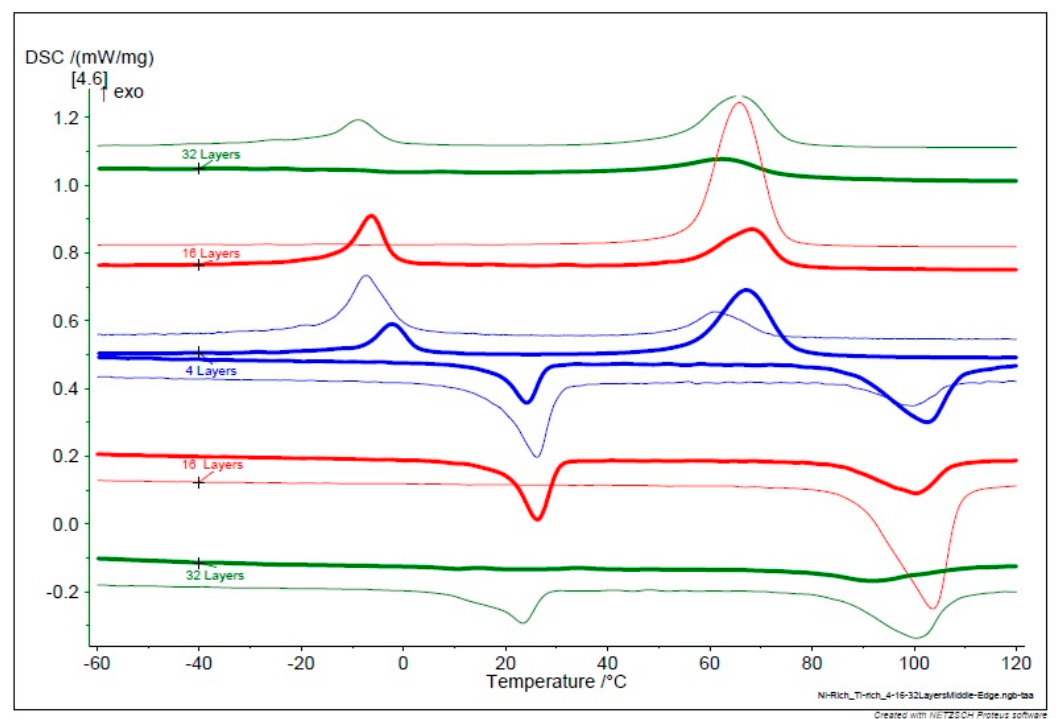
Figure 6. DSC curves for the 32 layers of Ni 50.3 Ti / Ni 49.6 Ti composite after HSHPT. Thicker lines: center sample; thinner lines: edge sample.